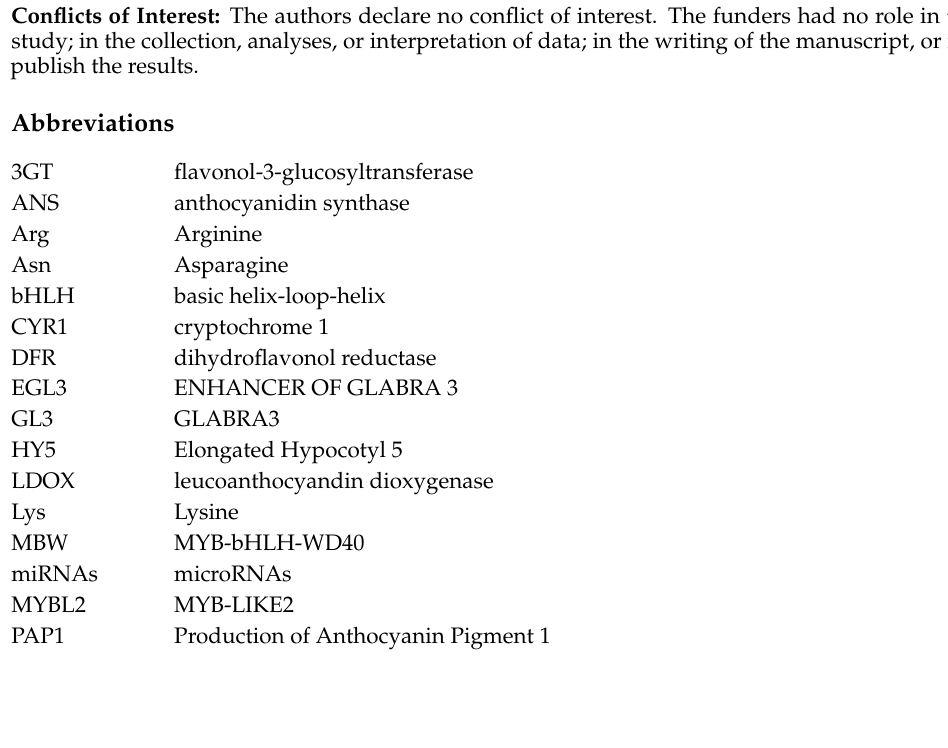
Figure S1: The prediction stem-loop structures of premiR828 homologs isolated in Brassica rapa by mfold, Figure S2: Comparison of miR828 sequences in turnip, Arabidopsis and tomato, Figure S3: The complementarity binding profiles for BrmiR828 with BrTAS4 and for TAS4-D4 ( − ) with Bra001917 (BrPAP2), Bra039763 (BrPAP1) and Bra004162 (BrPAP2), Table S1: Primers for premiR828, TAS4 and Real-time PCR primers for detected miR828 and targeted genes, Table S2: Nest primers for RLM 5 (cid:48) -RACE PCR used in this topic. Table S3: Full-length amino acid sequences of MYBs from Arabidopsis and Brassica rapa